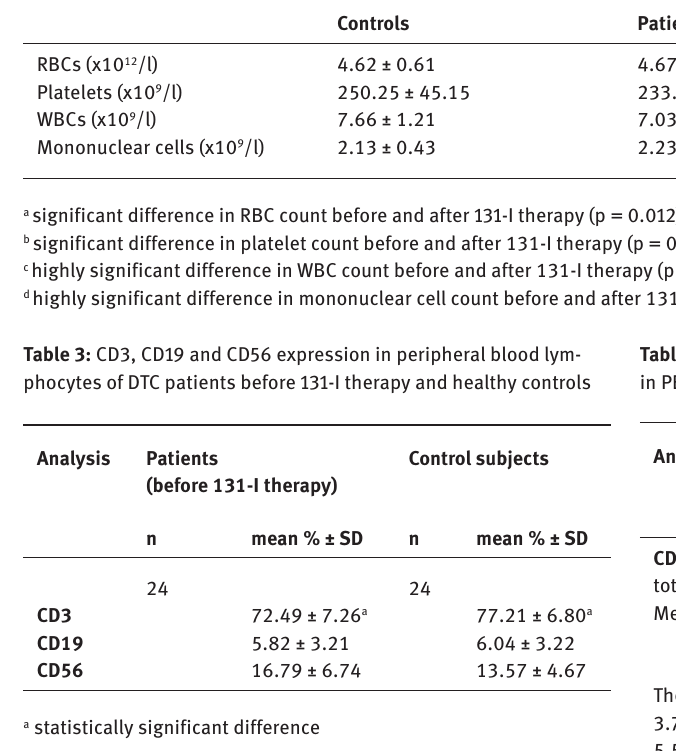
Controls Patients before 131-I Patients after 131-I RBCs (x10 12 /l) Platelets (x10 9 /l)